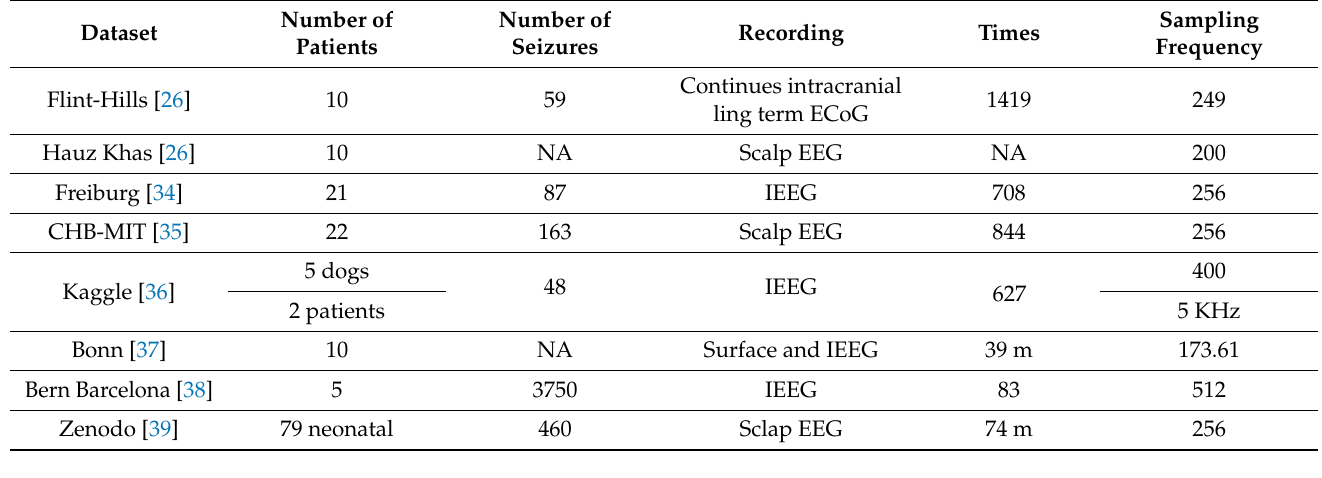
Table 1. Review of popular and available EEG datasets for epileptic seizures detection.